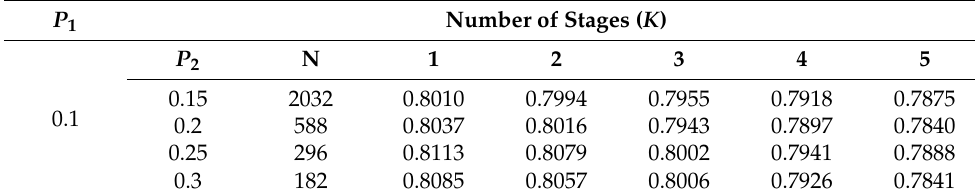
Table 6. Power values for the OWMP with α = 0.01, P 1 = 0.1, and P 2 = 0.15, 0.2, 0.25, 0.3.